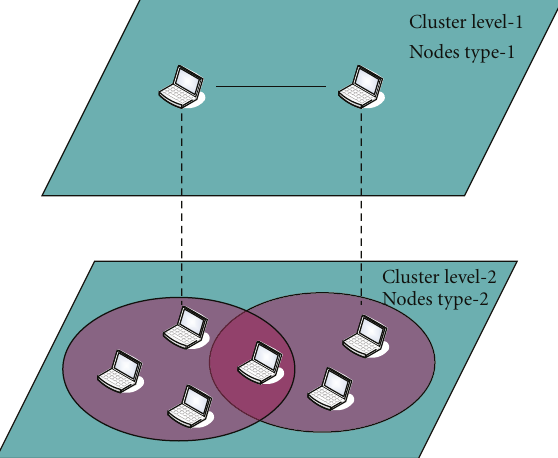
Figure 13: Hierarchical network design.